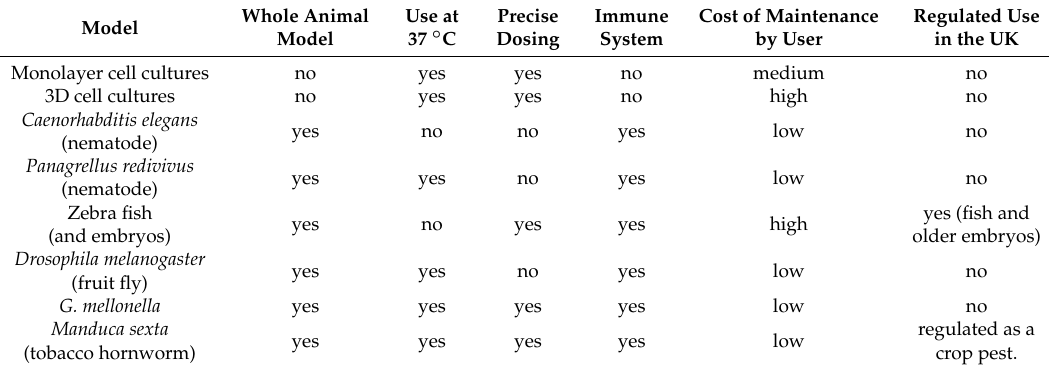
Table 1. Comparison of alternative infection